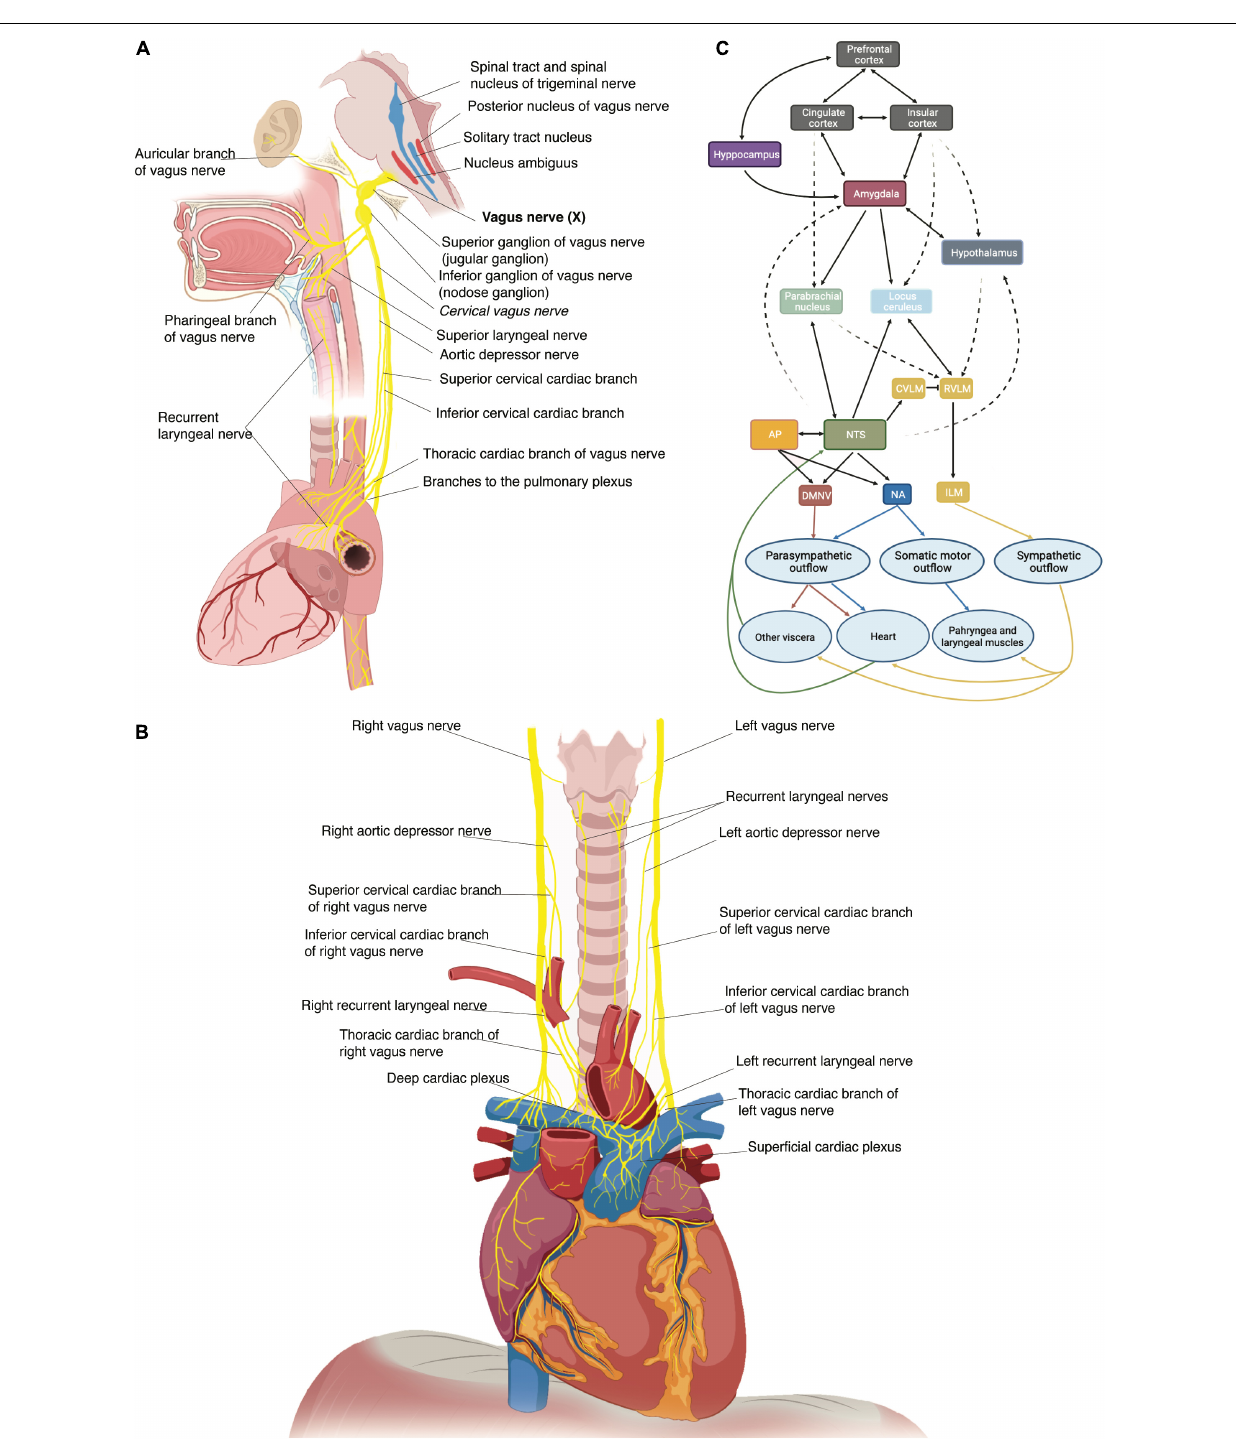
FIGURE 1 | (A) Schematic representation of the origin of the vagus nerve from the medulla, its ganglia and its major branches at the cervical and thoracic levels. (B) Thoracic vagus nerves with cervical and thoracic cardiac branches to the deep and superficial cardiac plexi and recurrent laryngeal nerves. (C) Schematic representation of the central autonomic network with internuclei connections. An autonomic vagovagal loop comprises visceral inputs to the nucleus tractus solitarii (NTS) which then sends outputs to the dorsal motor nucleus (DMNV), rostral ventrolateral medullary (RVLM), and intermediate lateral medulla (ILM) to adapt autonomic balance to physiological demands. The cross-talk between the NTS and brain regions (hypothalamus, amygdala, cingulate cortex, insula, prefrontal cortex) engaged in neuroendocrine, affective, and cognitive regulation of behavior modulates this autonomic forebrain loop. AP, area postrema; NA, nucleus